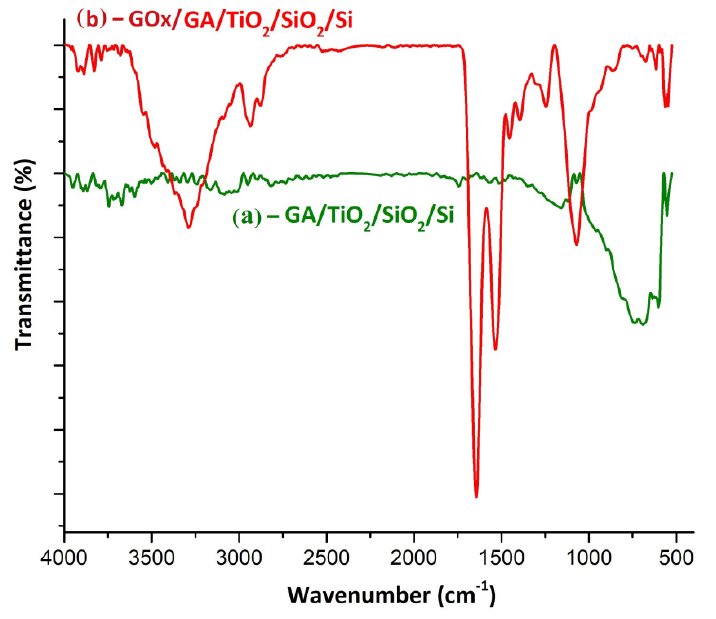
Figure 9. FTIR spectra for ( a ) a representative sample of GA deposited on nanostructured TiO 2 film and ( b ) for GOx anchored to the GA–TiO 2 probe.